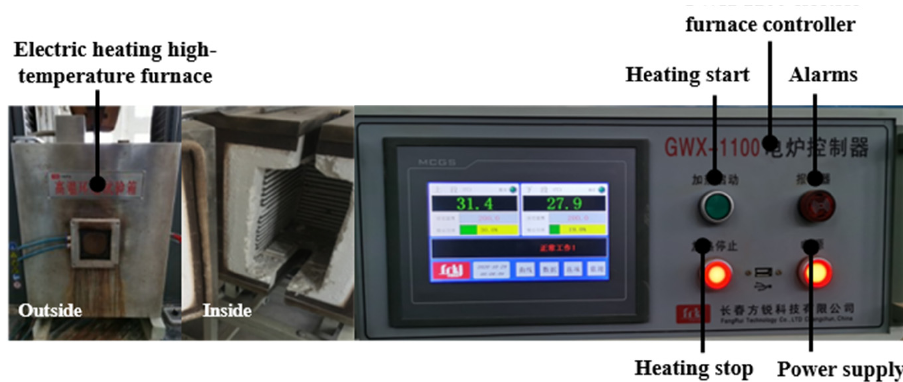
Figure 3. Diagram of the electric heating high-temperature furnace and electric furnace controller.